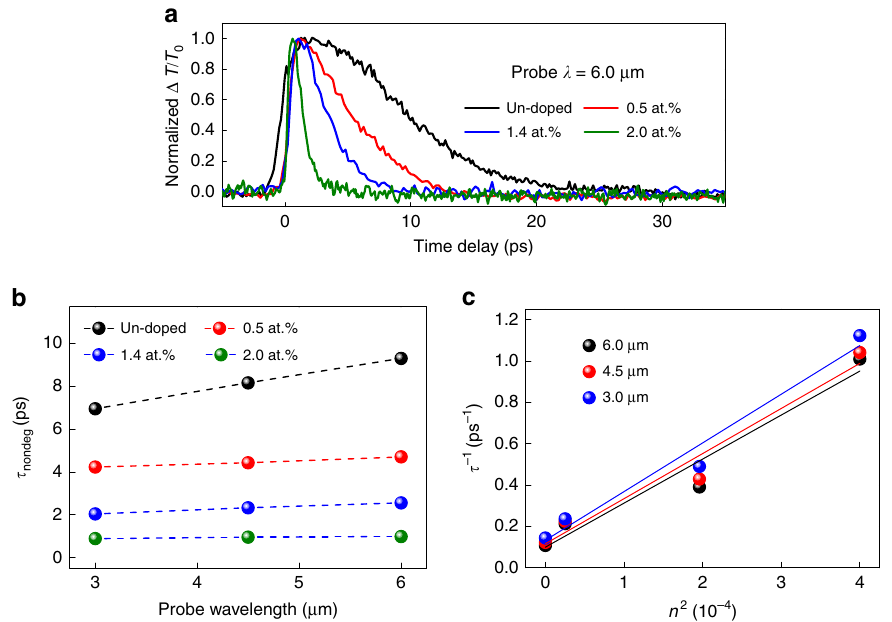
Figure 3 | Relaxation time customization by element doping. ( a ) Time-resolved D T / T 0 traces at a probe wavelength of 6.0 m m for the Cd 3 As 2 samples with different Cr concentrations, showing faster photocarrier relaxation times for higher Cr concentrations. ( b ) The fitted recovery time constants as a function of Cr concentration at probe wavelengths of 3.0, 4.5 and 6.0 m m. The data points obtained from the same sample are connected by dashed lines to guide the eye. ( c ) Linear relationship between the inverse relaxation time t (cid:2) 1 and the square of the doping concentration n 2 . The lines (linear fitting) reveal that the scattering rate agrees with the equation t (cid:2) 1 total ð Þ ¼ t (cid:2) 1 0 ð Þþ D D 2 , where D is the doping-induced band gap and t (cid:2) 1 0 ð Þ and D are constants that t t t are independent of the band